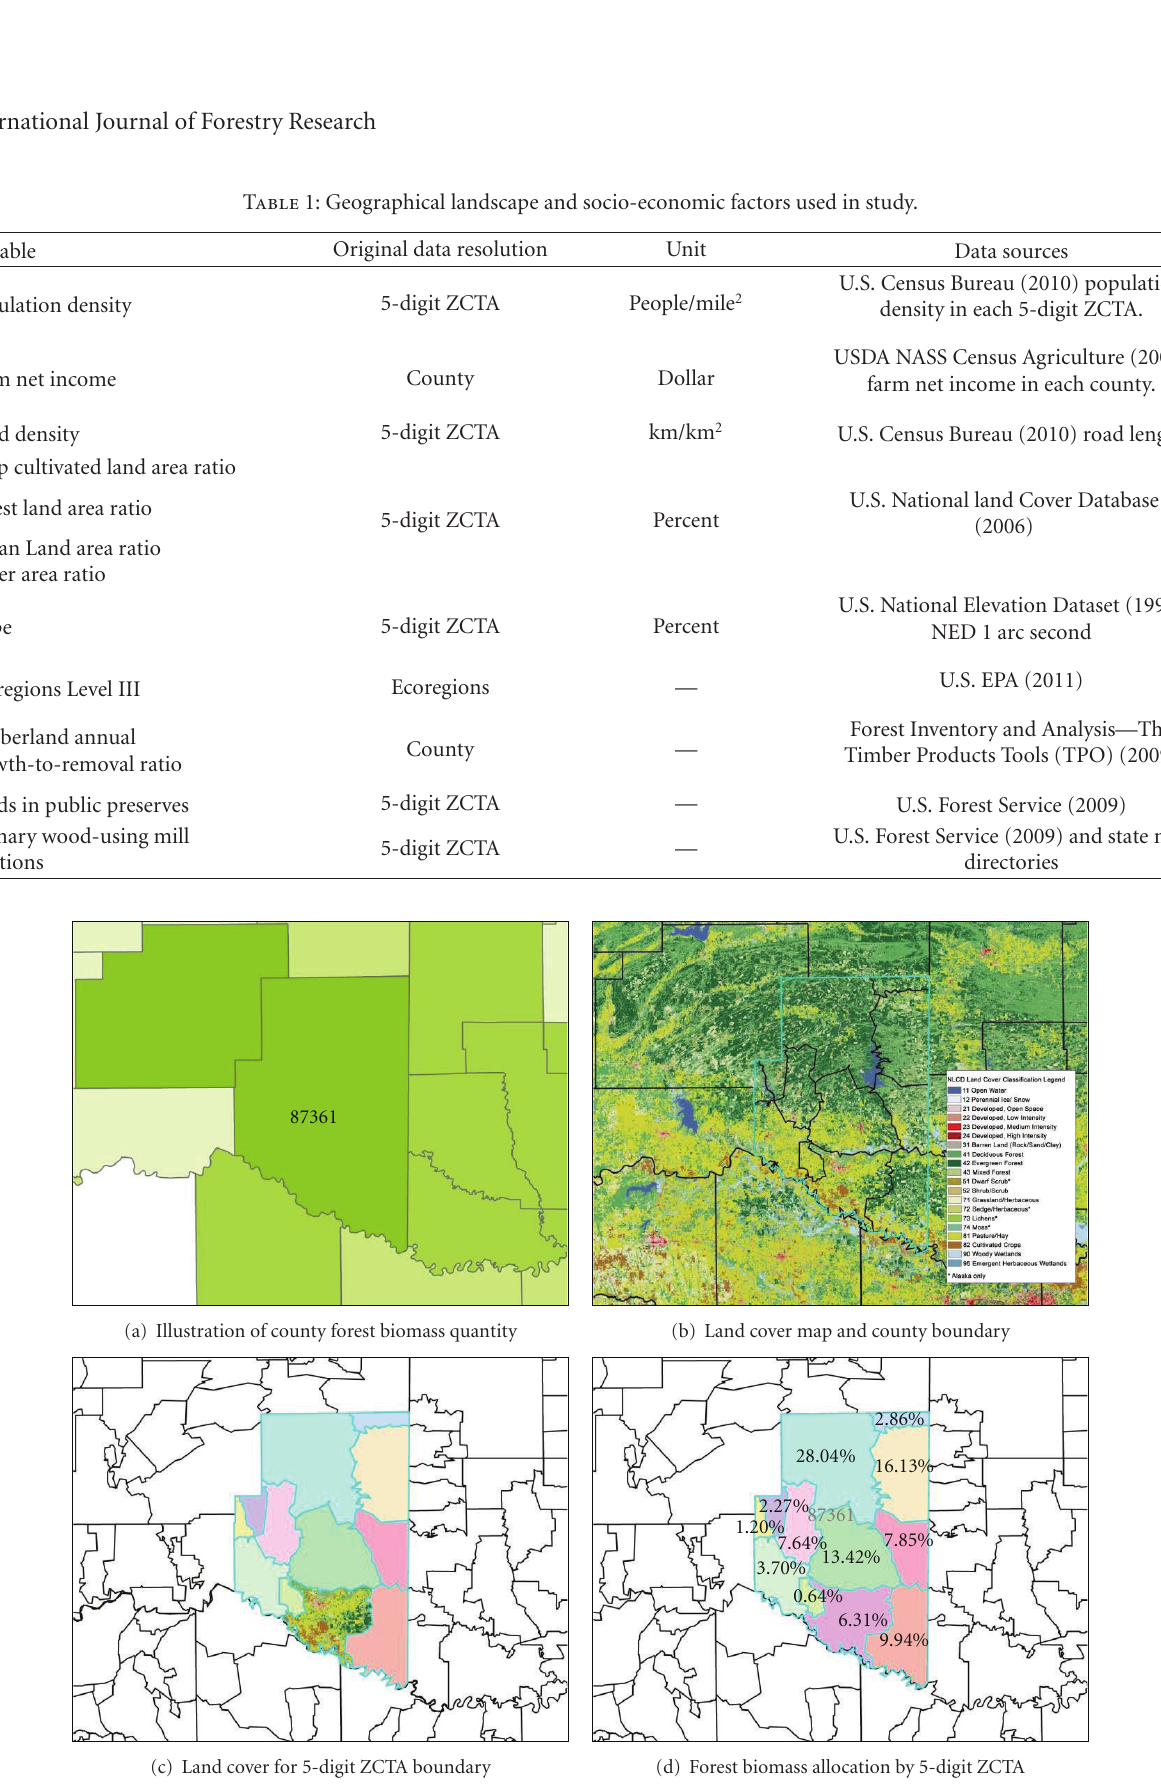
Figure 1: Illustration of forest biomass allocation at the level of 5-digit